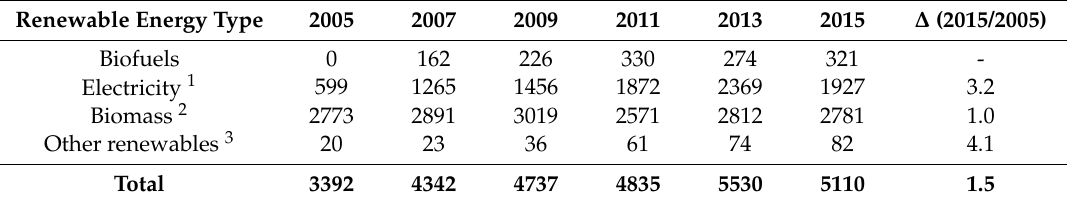
Table 4. Portuguese annual production of energy from renewable sources (ktoe) from 2005 to 2015 [3]. Renewable Energy Type